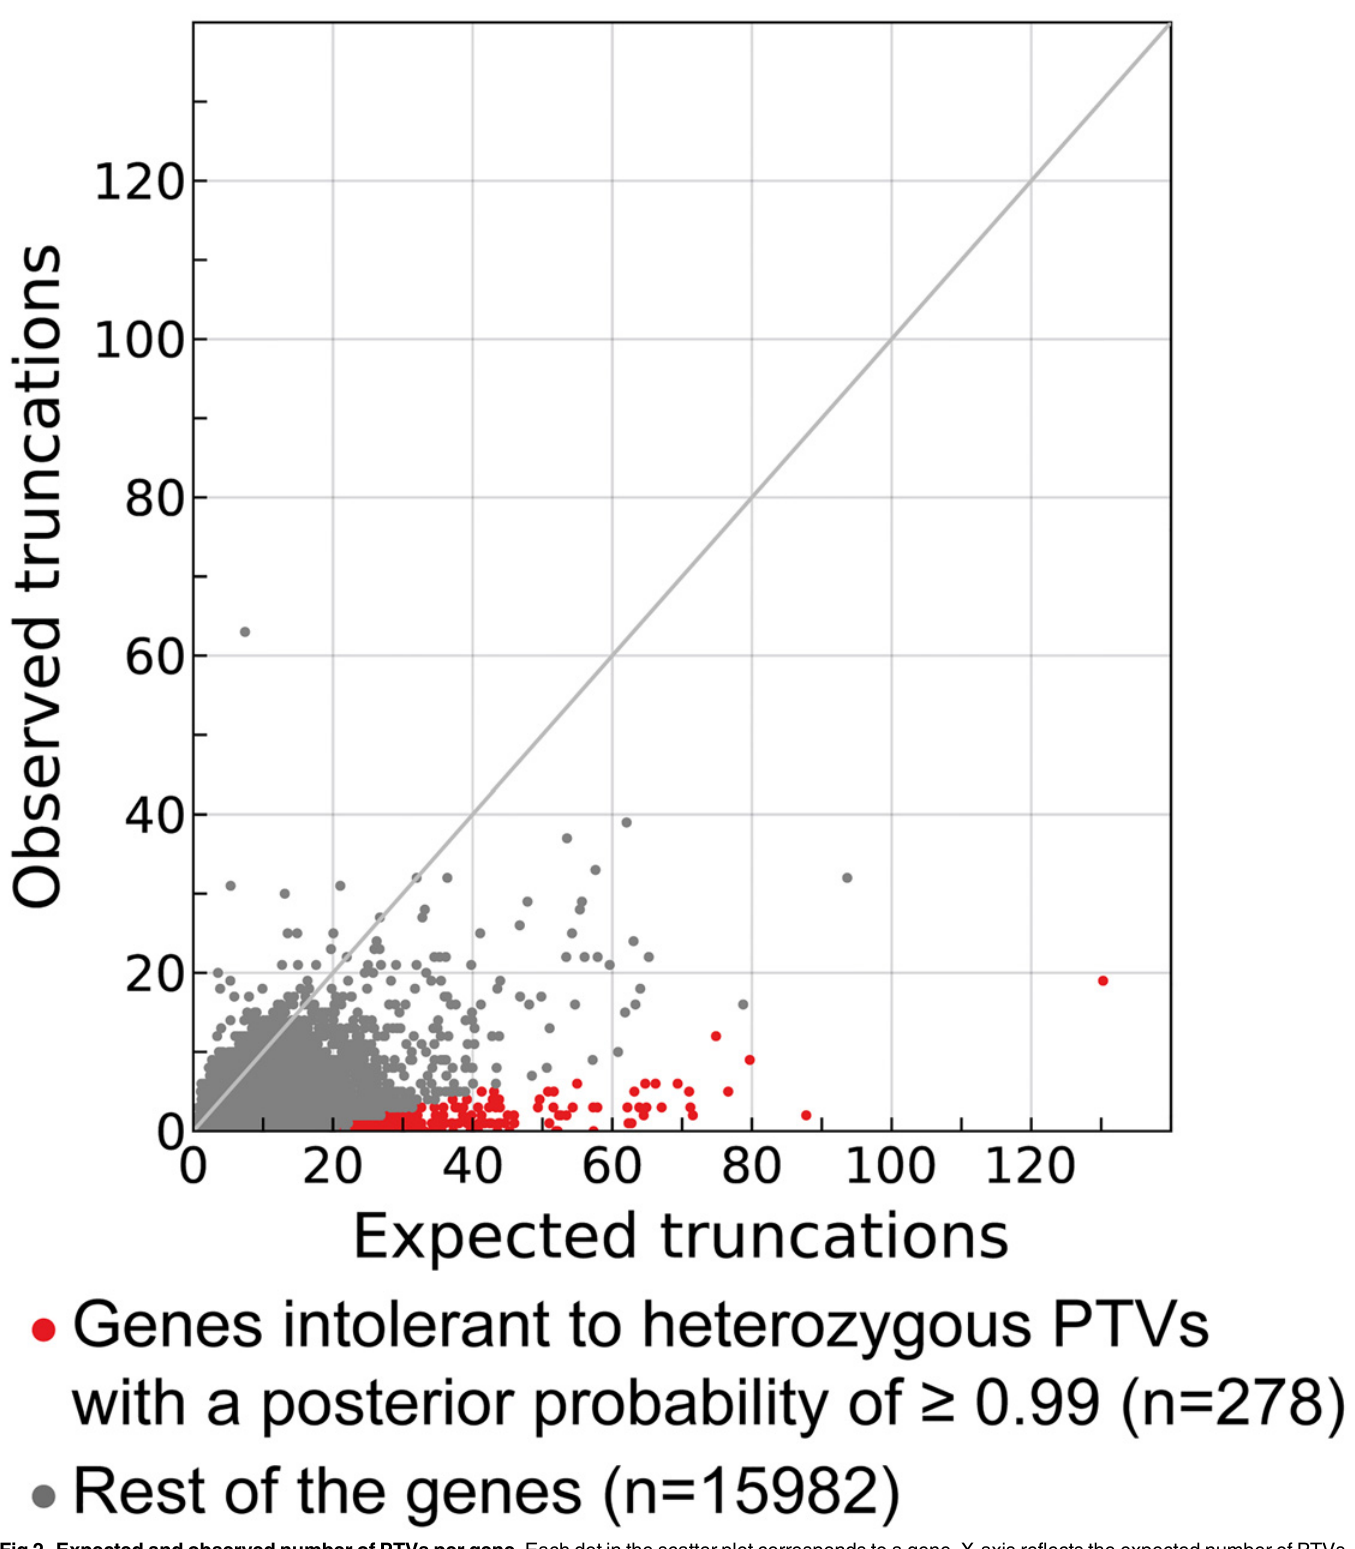
Fig 2. Expected and observed number of PTVs per gene. Each dot in the scatter plot corresponds to a gene. X-axis reflects the expected number of PTVs for each gene according to a model of neutral variation based on synonymous variants (Model B, see Methods) while on Y-axis indicates observed number